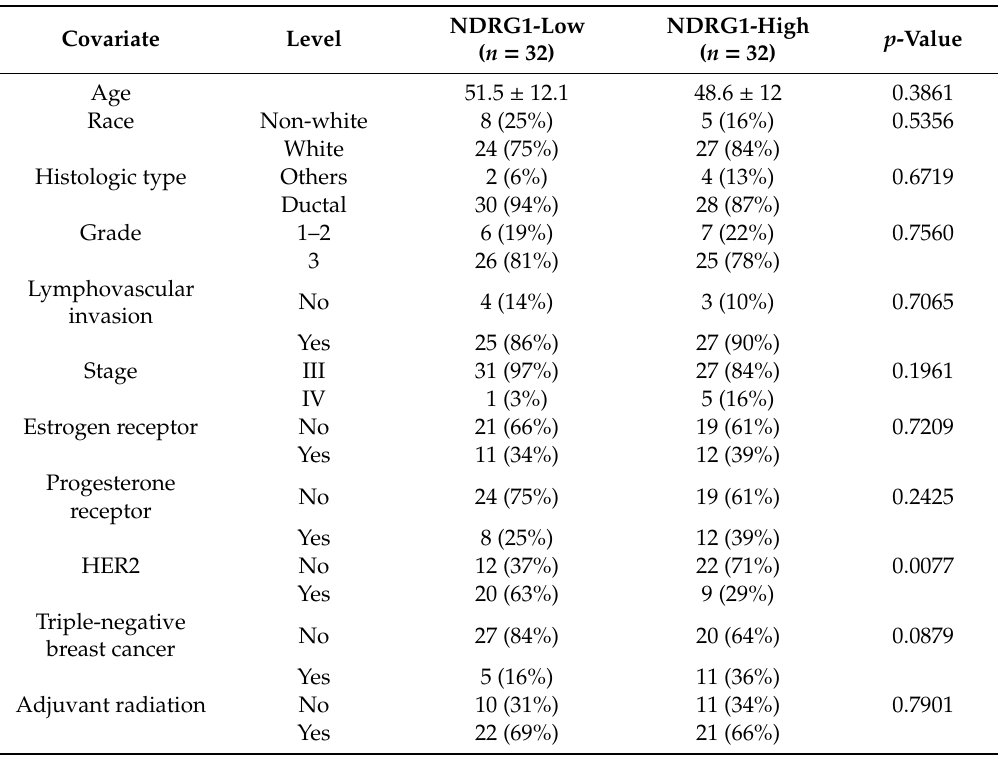
Table 1. Clinical and pathologic characteristics of tumor samples from patients with IBC according to NDRG1 expression.